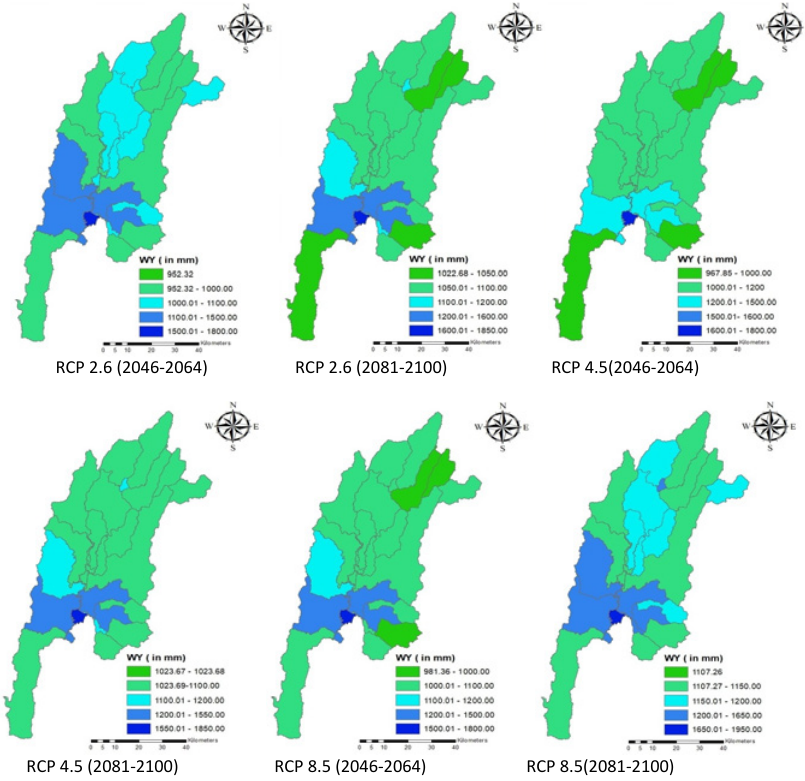
Fig. 9: Spatial distribution of water yield under different RCP scenarios for different time period